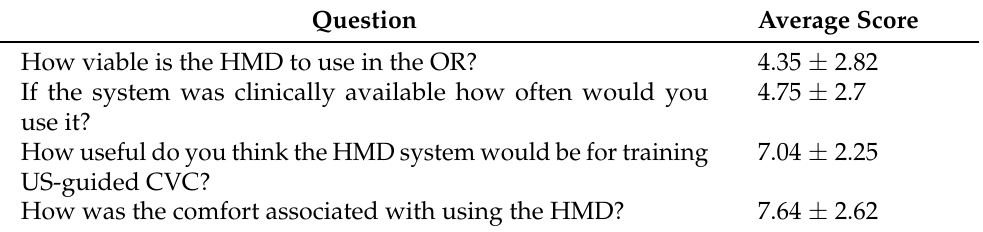
Table 5. User questionnaire results scored out of 10, with 10 being the best score.